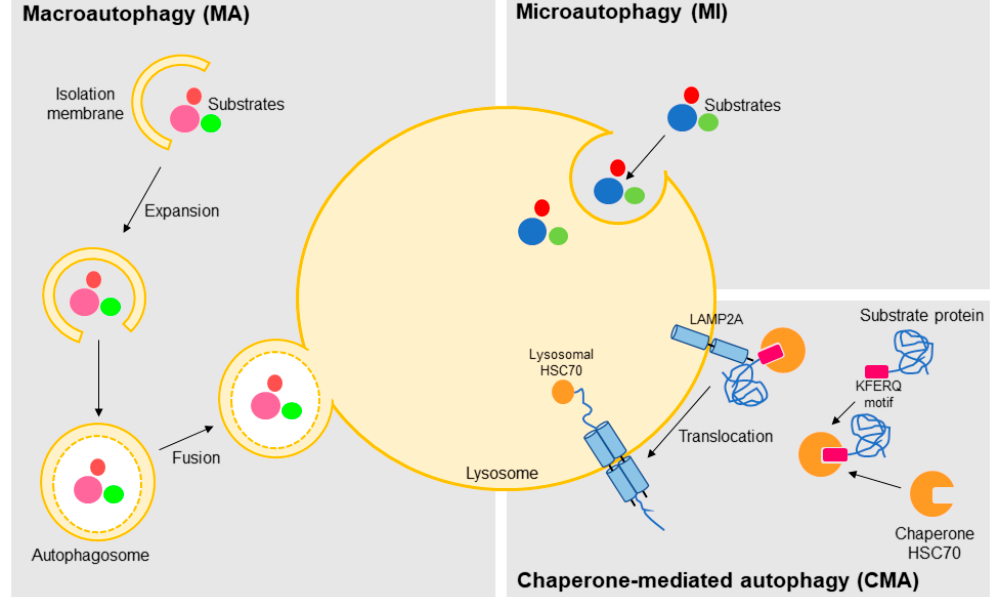
Figure 1. The different autophagy sub-types. Autophagy, which is a lysosomal-mediated degradation of intracellular compounds, is classified according to the way the cargo is carried to the lysosome lumen in macroautophagy (inside double-membrane vesicles termed autophagosomes), microautophagy (directly by local rearrangement of lysosomal membrane), and chaperone-mediated autophagy (by binding of the KFERQ motifs of the substrate proteins to the chaperone HSC70 (heat shock cognate protein of 70-kDa) and translocation across the lysosome mediated by the lysosome-associated membrane protein type 2A, LAMP2A).